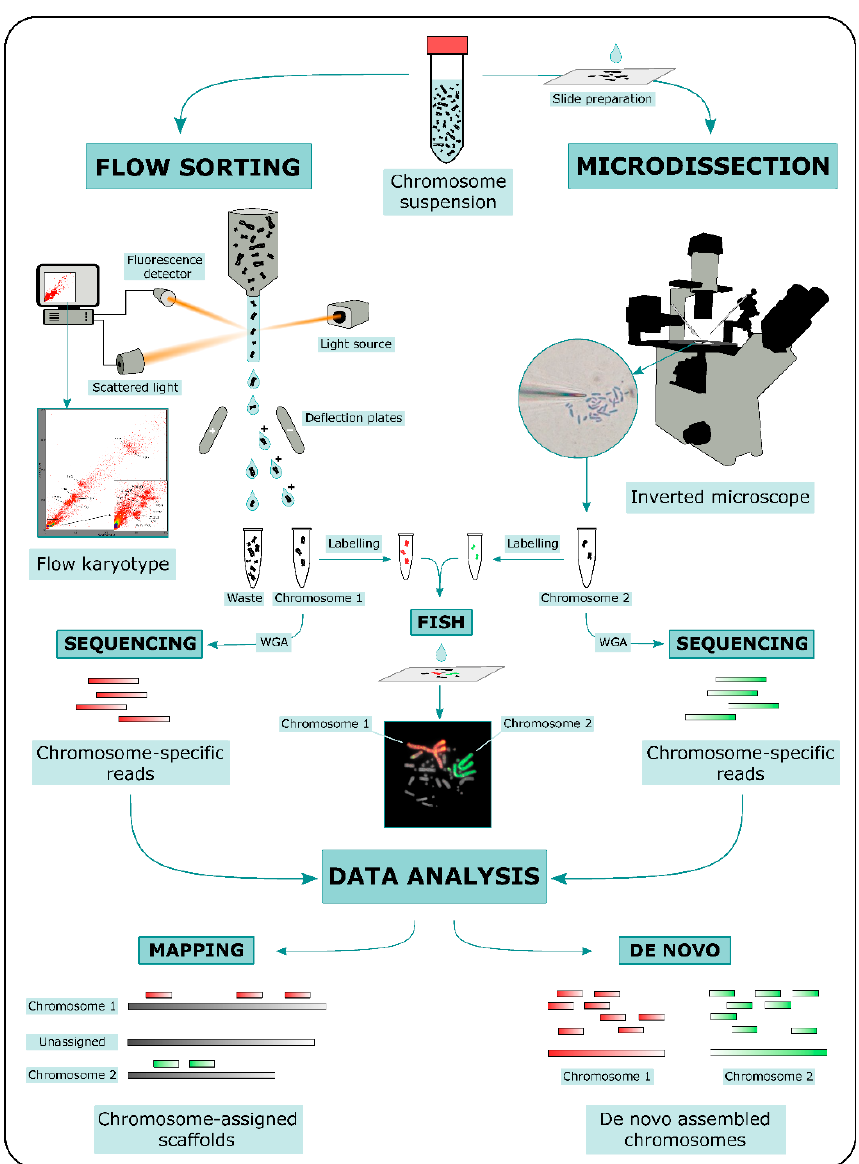
Figure 1. Schematic representation of ChromSeq workflow. Briefly, chromosomes are isolated via either flow sorting or microdissection (only mechanical microdissection is shown). After isolation, Whole-Genome Amplification (WGA) is performed on chromosomal DNA. Eventually, chromosomal DNA can be labeled with fluorochromes and hybridized onto the target species metaphases to confirm the identity of isolated chromosomes. WGA products are then sequenced with next generation sequencing technologies. Sequencing data can be mapped on the target species reference genome or assembled de novo . The latter approach has proven successful when a combination of high throughput chromosome isolation (millions of copies) and long-read sequencing approaches are implemented.